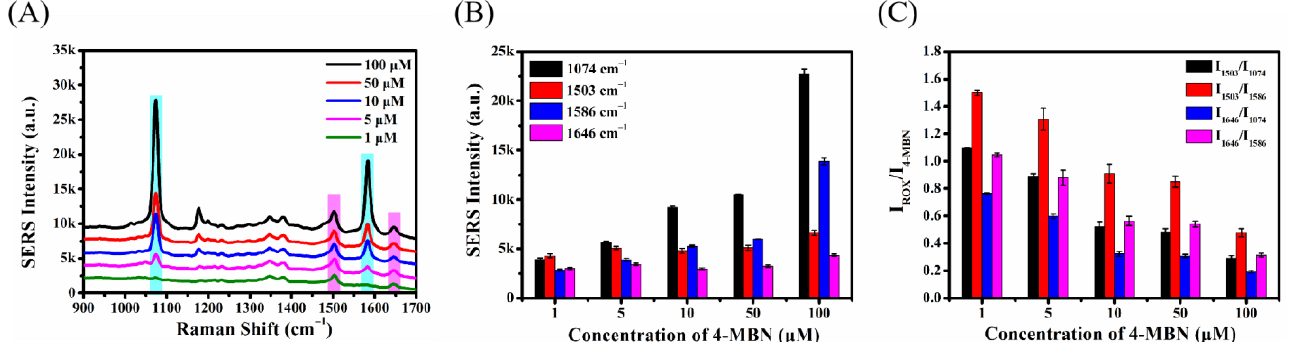
Figure 4. Results of optimizing the concentration of 4-MBN used to prepare the SERS probe. ( A ) SERS spectra of probes prepared with 4-MBN at the concentration of 1–100 µ M. ( B ) Intensities of the characteristic SERS signals of ROX at Raman shifts of 1503 cm −1 and 1646 cm −1 and 4-MBN at Raman shifts of 1074 cm −1 and 1586 cm −1 . ( C ) Ratios of the SERS signal intensities of ROX to 4-MBN.